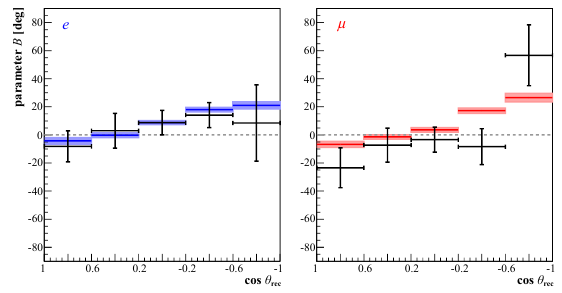
Figure 7. The parameter, B , depending on the cosine of the zenith angle, for e -like (left) and µ -like (right) events, from the Super-K data (points with statistical error) and MC simulations (boxes with systematic